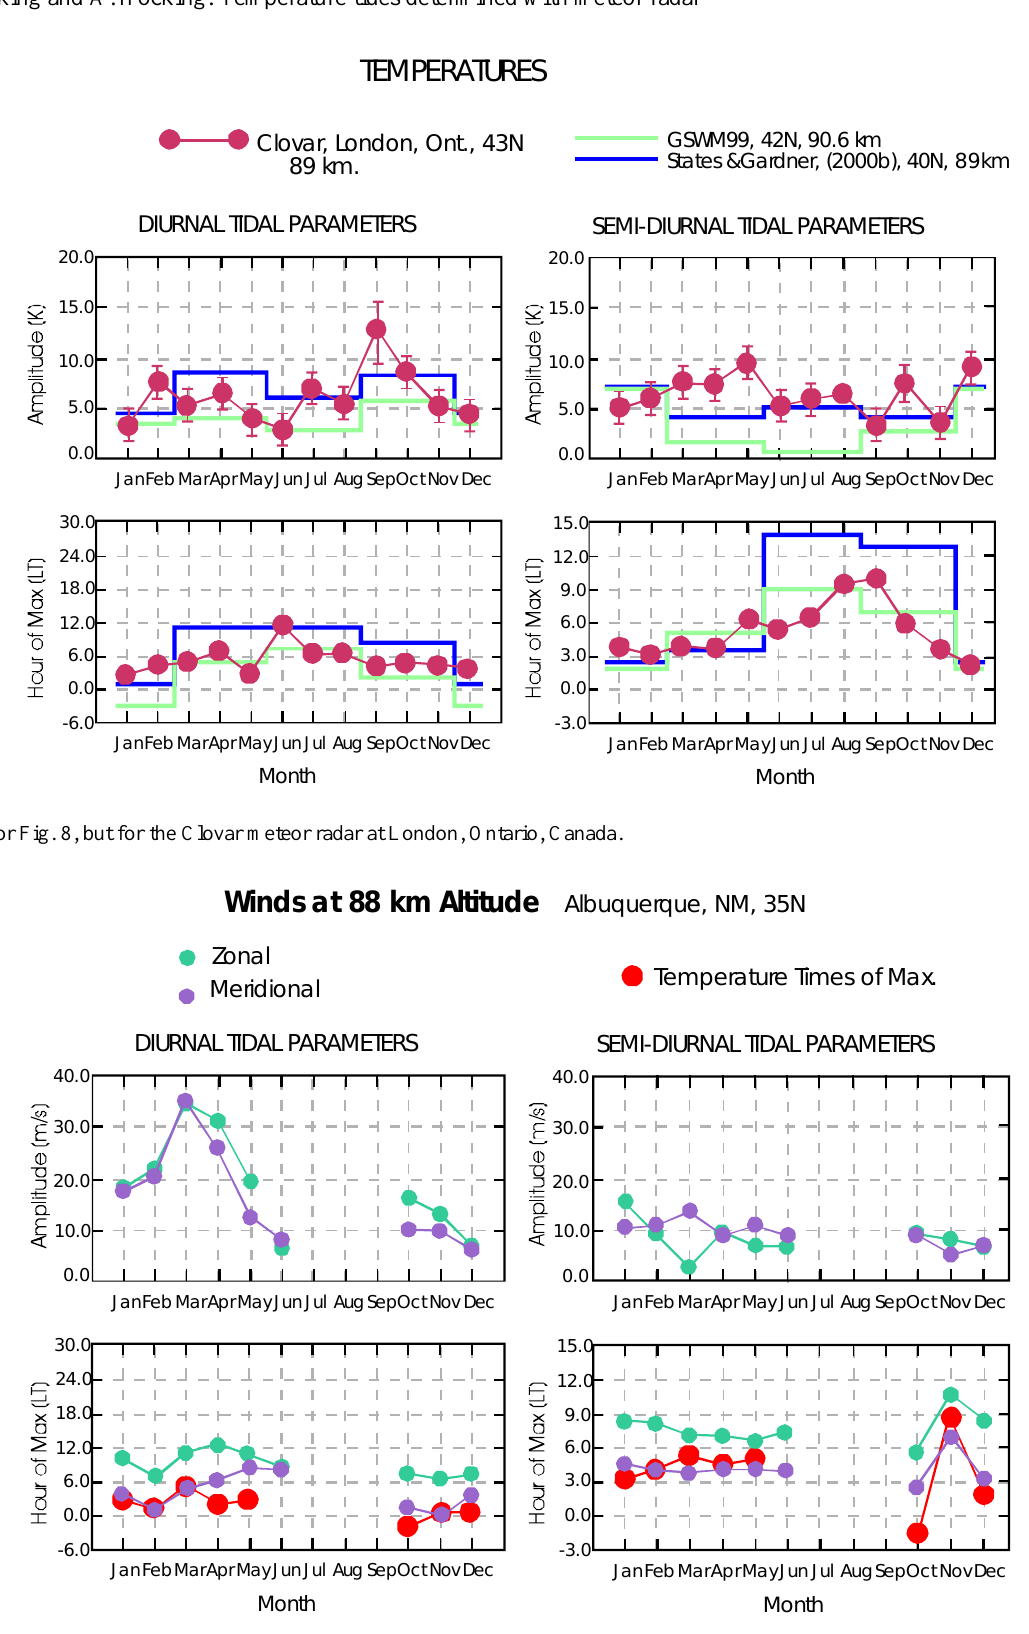
c:\wkh\egs\mtidef10.cdr